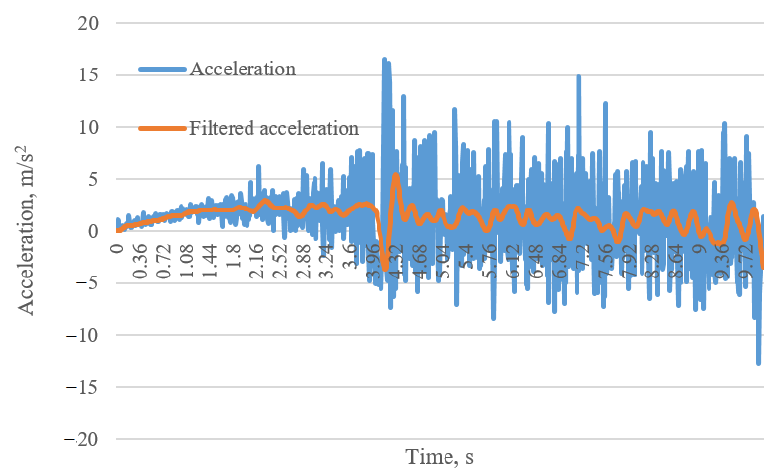
Figure 6. Second test acceleration results with and without the filter.